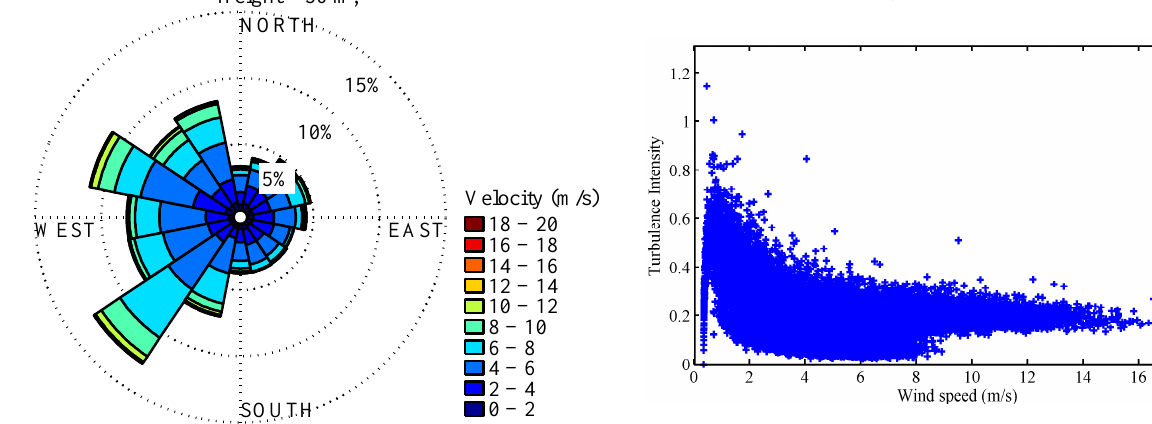
Figure 9: Turbulence intensity using IoT.